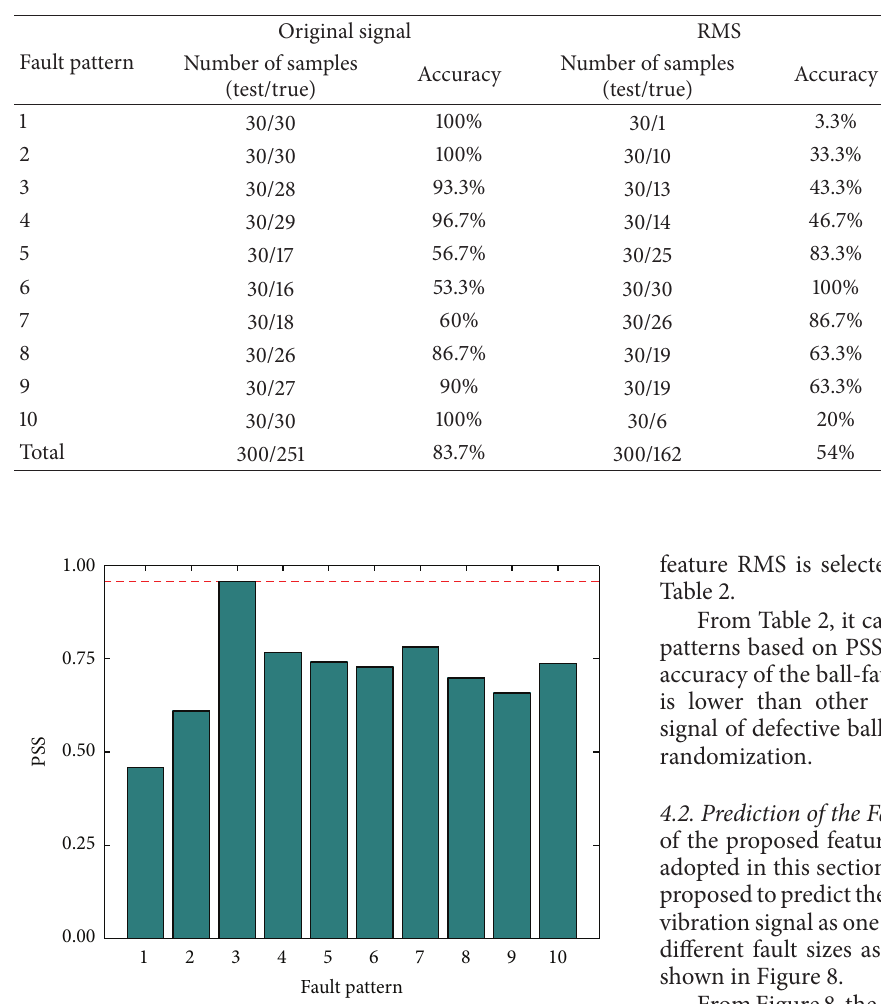
Figure 6: (a) Curve of 𝐸 1 (𝑑) and 𝐸 2 (𝑑) and (b) curve of 𝐶 𝑖 (𝜏) . Table 2: Results of rolling bearing fault pattern recognition.